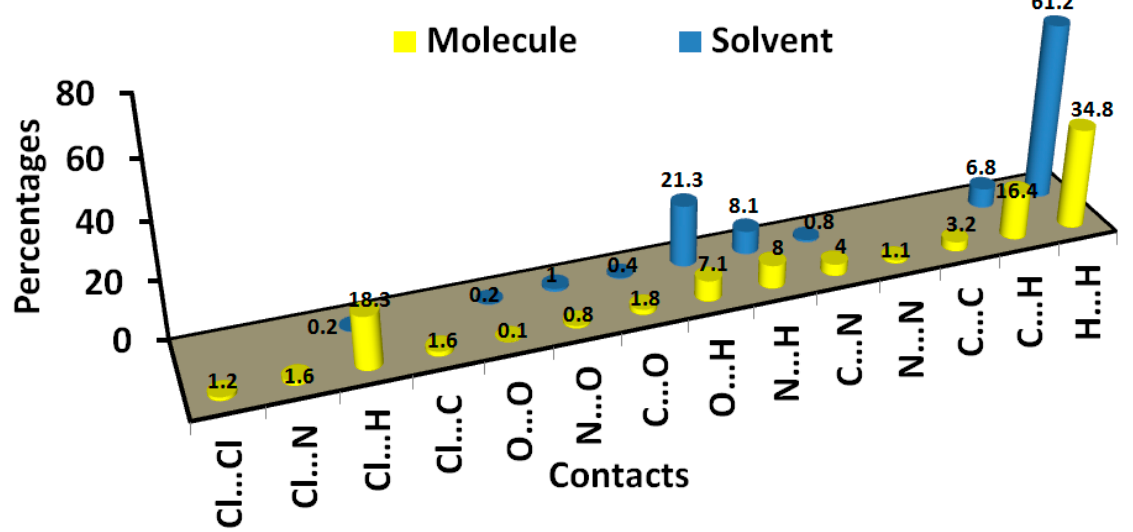
Figure 7. Intermolecular contacts and their percentages in 6c .